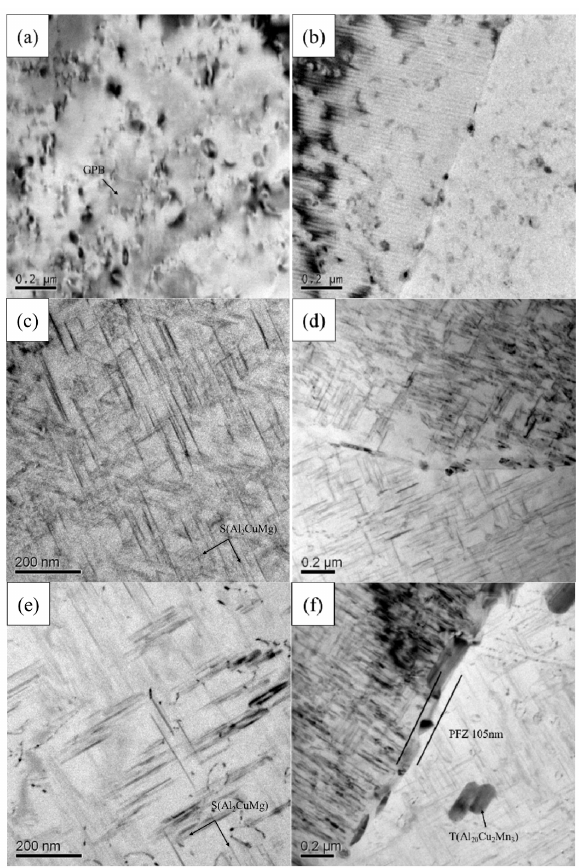
Figure 11. TEM micrographs of Al-Cu-Mg alloy under 180 MPa after 12 h of creep aging at different temperature: ( a , b ) 160 ◦ C; ( c , d ) 180 ◦ C; ( e , f ) 200 ◦